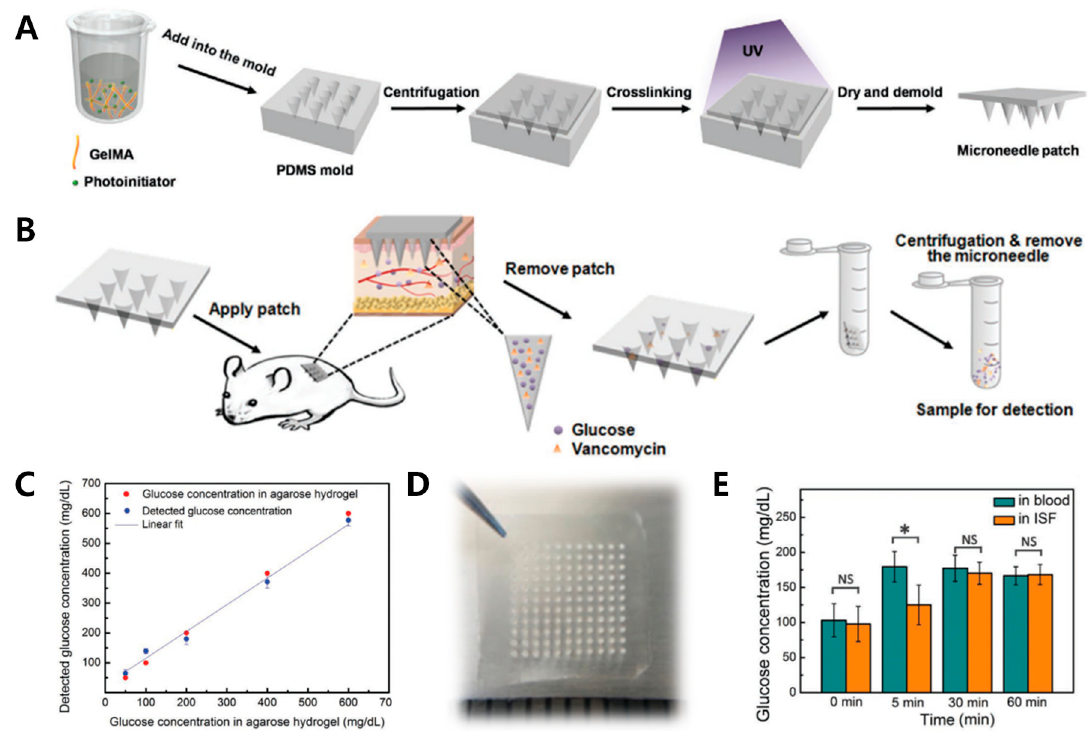
Figure 13. Gelatin methacryloyl microneedle patches for minimally invasive extraction of skin interstitial fluid. ( A ) Preparation process of the GelMA MN patch. ( B ) Schematic diagram of the extraction process in a rat model. ( C ) The detected glucose concentration (blue dots) was fitted as a line (blue line), R 2 = 0.981. ( D ) A picture of the GelMA MN patch containing an 11 × 11 array of MNs over a 1 cm × 1 cm area. ( E ) Detected glucose concentrations in ISF compared to blood glucose concentrations. * p < 0.05, NS means not significant. Adapted with permission [147]. Copyright 2020, Small.